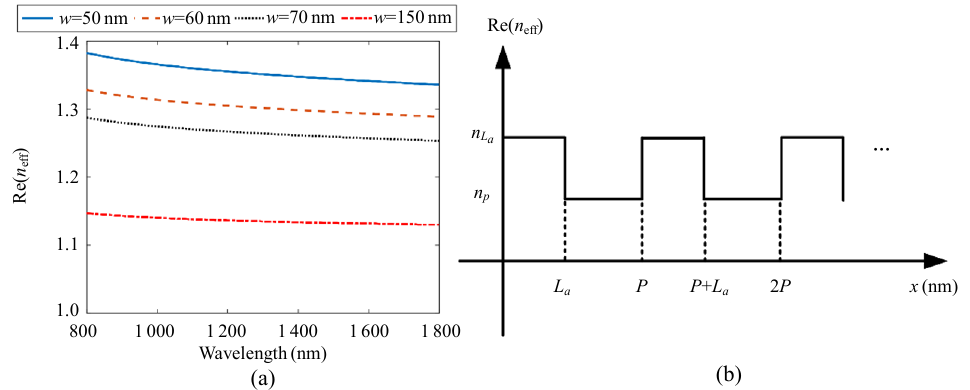
Fig. 2 Relationship between Re( ) n and the wavelength or the waveguide: (a) eff defining the waveguide width as W = 50 nm, 60 nm, 70 nm, and 150 nm, respectively and (b) variation of MIM